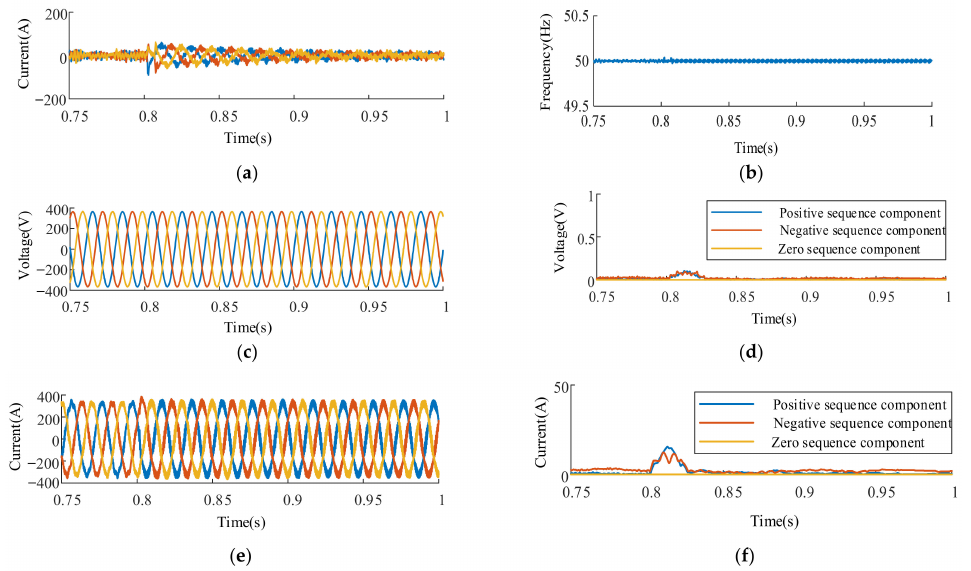
Figure 6. Simulated waveforms with the local load mutation: ( a ) The current flowing into the grid; ( b ) System’s voltage frequency; ( c ) The voltage at the PCC; ( d ) The second harmonic symmetrical com- ponents of the measured voltage; ( e ) Inverter output current; ( f ) The second harmonic symmetrical components of the measured